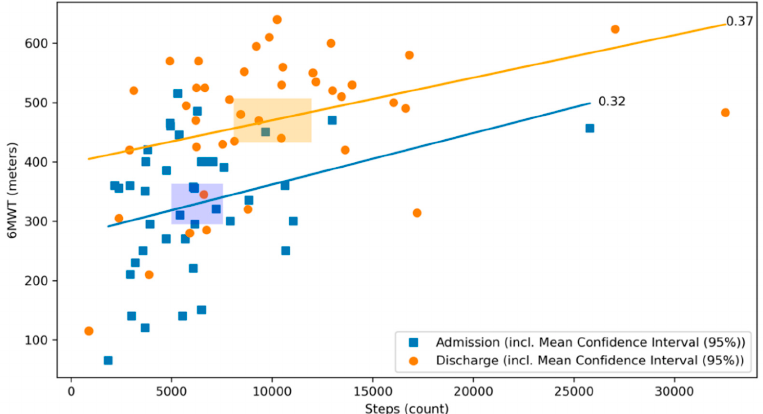
Figure 4. Scatterplot of 6MWT and step count at admission and discharge with respective correlation coefficients. The relationship between the 6MWT and the step count at admission (blue) and discharge (orange) of the CR stay are illustrated. The graph visualizes their respective correlation coefficients. Blue dots represent patients at admission, whereas orange dots represent patients at discharge. The lines depict the correlation coefficient between the 6MWT and the step count at admission in blue and at discharge in orange. The rectangles represent the mean confidence intervals of the respective means (r = 0.32, p = 0.04 and 0.37, p = 0.02,